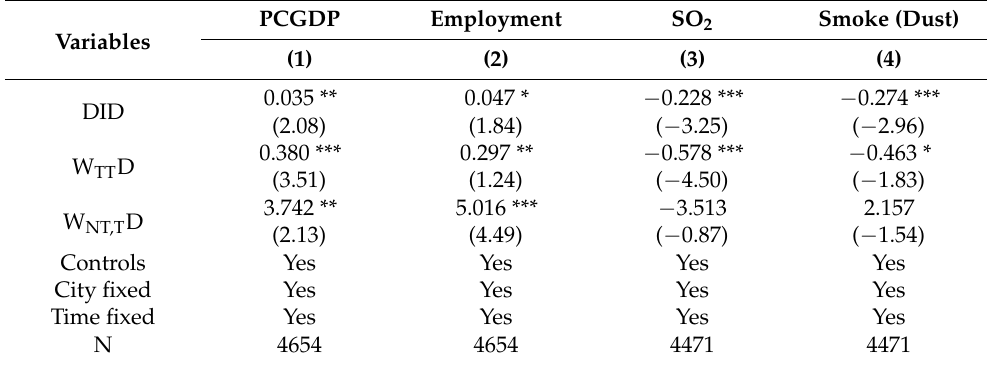
Table 8. The results of spatial